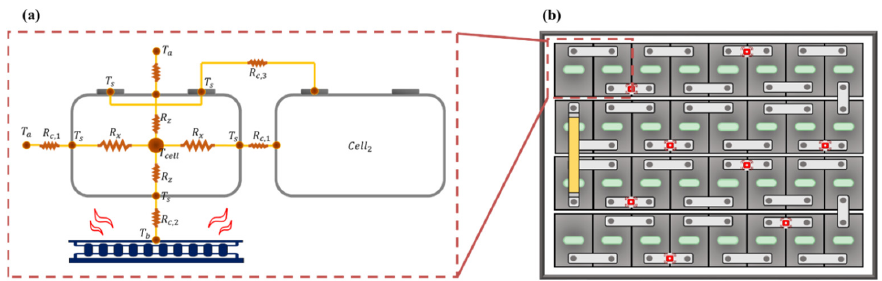
Figure 2. The thermal model of the battery and module. ( a ) Single battery model. ( b ) Battery module model.